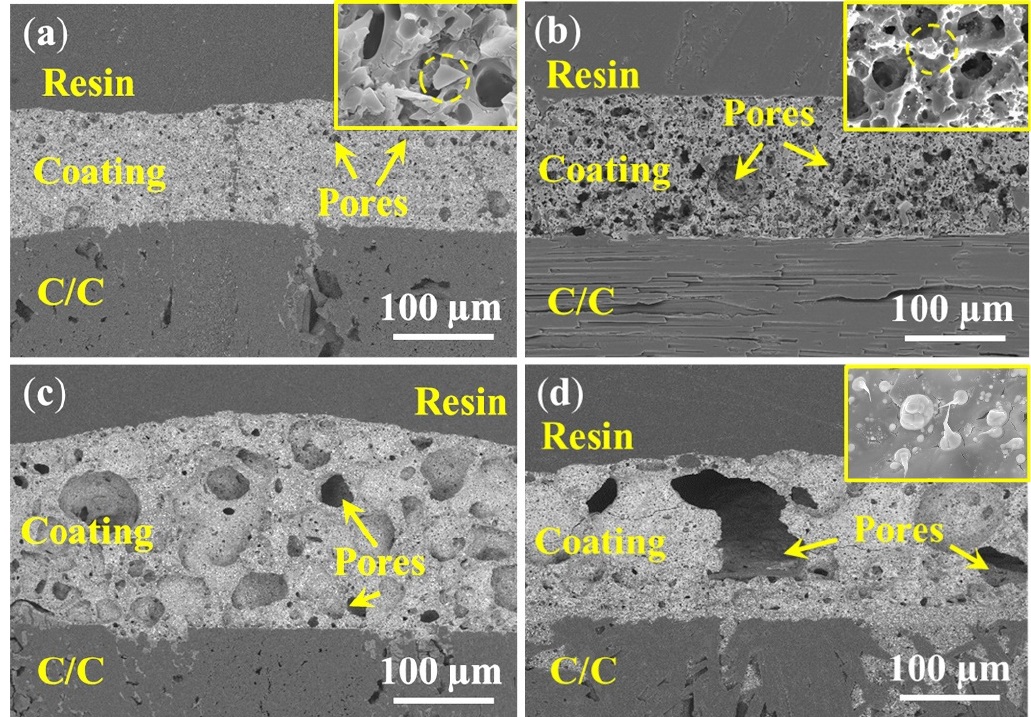
Figure 8. Cross-sectional images of PSN/bismuth–borosilicate glass–B 4 C coatings with different bismuth content after oxidation at 500 °C for 2 h in air: ( a ) Bi10; ( b ) Bi20; ( c ) Bi30; and ( d ) Bi40.